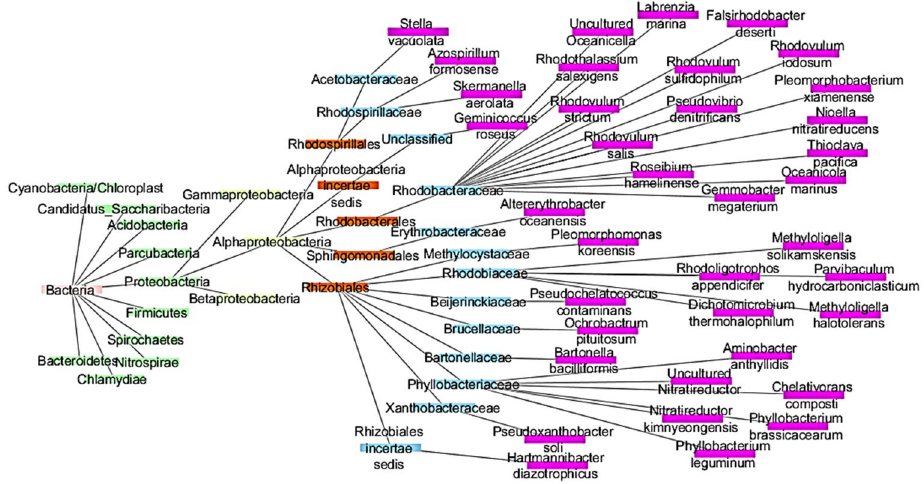
Figure 6. Network based metagenome hierarchy highlights the abundance of Alphaproteobacteria (coloured in Sample collection and sponge identification. Desmospongiae is the most predominantly found sponge class in Palk Bay, and two most commonly available sponge species belonging to this class were selected for this microbiome study. Around 0.5 g of representative sponge samples (belonging to two commonly available sponge species) were collected by snorkelling (three specimens from each representative sponge species) during May 2016. Sponge samples were transported to the laboratory as two sets, one in DMSO-EDTA saline saturated (DESS) 44 solution and other in ice (4 °C). For DNA extraction, samples were preserved in DESS solution while transporting to maintain DNA integrity. For sponge identification, the samples were rinsed first with filter- sterilized seawater to remove debris and then stored in ice during transportation. After reaching the laboratory, both the samples were stored at -80 °C until further processing, sponge samples transported in DESS solution were first rinsed with filter-sterilized seawater to remove excess salts and to prevent interference of salts during DNA extraction. All sponge samples were collected from a depth of about 2 m. Sponge samples (about 0.5 cm) transported in ice were treated with 1.5 ml sodium hypochlorite (30%, v/v) solution for tissue digestion. After 1 h incubation, the tubes were centrifuged at 4,000 rpm for 5 min (Eppendorf) and then washed twice with sterile distilled water to remove cell debris. The suspension was visualized under light microscope to observe the sponge species-specific distinctive spicule morphology. The spicule morphology was recorded and photographed, then the spicule size was measured using KLONK Image Measurement software (version: 19.4.15.0). The two morphologically different sponge samples collected from Palk Bay coded as ‘Gr’ (pale grey in colour) and ‘Red’ (yellowish brown in colour) were identified based on spicule structure reports of Sivaleela 45 and marine species database (https ://www.marin espec ies.org). Sample processing and metagenomic DNA extraction. Sponge metagenomic DNA was isolated using the DNeasy plant DNA isolation kit (Qiagen GmbH, Hilden) following the manufacturer’s protocol. Totally, six samples of metagenomic DNA were subjected to Illumina Sequencing, in which three samples belong to G. pumila (Lendenfeld, 1887) 46 (coded as Gr1, Gr2, and Gr3) and three samples belong to C. lobata Hancock 47 (coded as Red1, Red2, Red3). The purity of the DNA samples was determined in a NanoDrop ND-2000 spec- trophotometer (Thermo Fisher Scientific, USA) and the DNA concentration was quantified by using a Qubit fluorimeter. PCR and Illumina next generation sequencing (NGS).